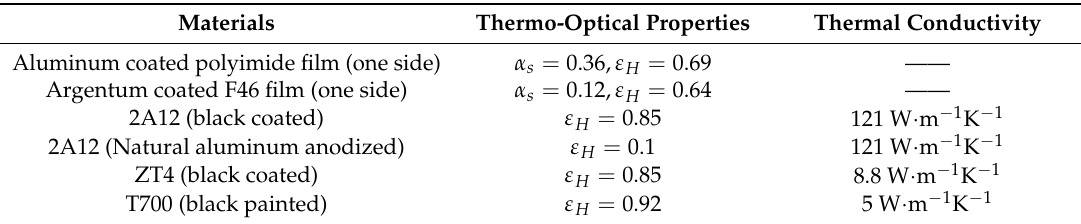
Table 3. Material properties of the thermal subsystem.